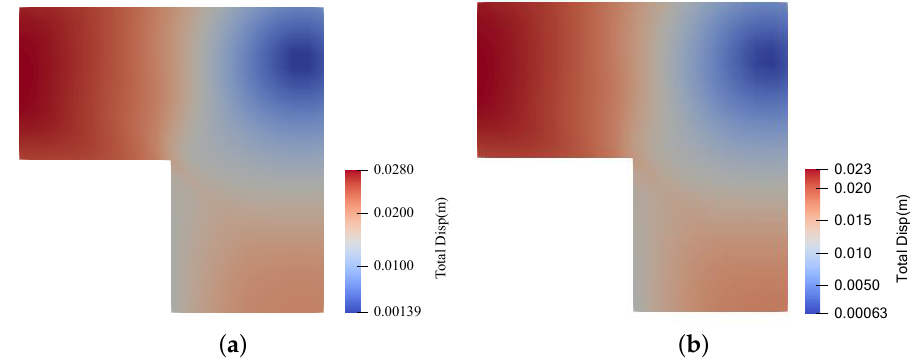
Figure 8. ( a ) The contour of displacement calculated using epSFEM and ( b ) the contour of displace- ment calculated using